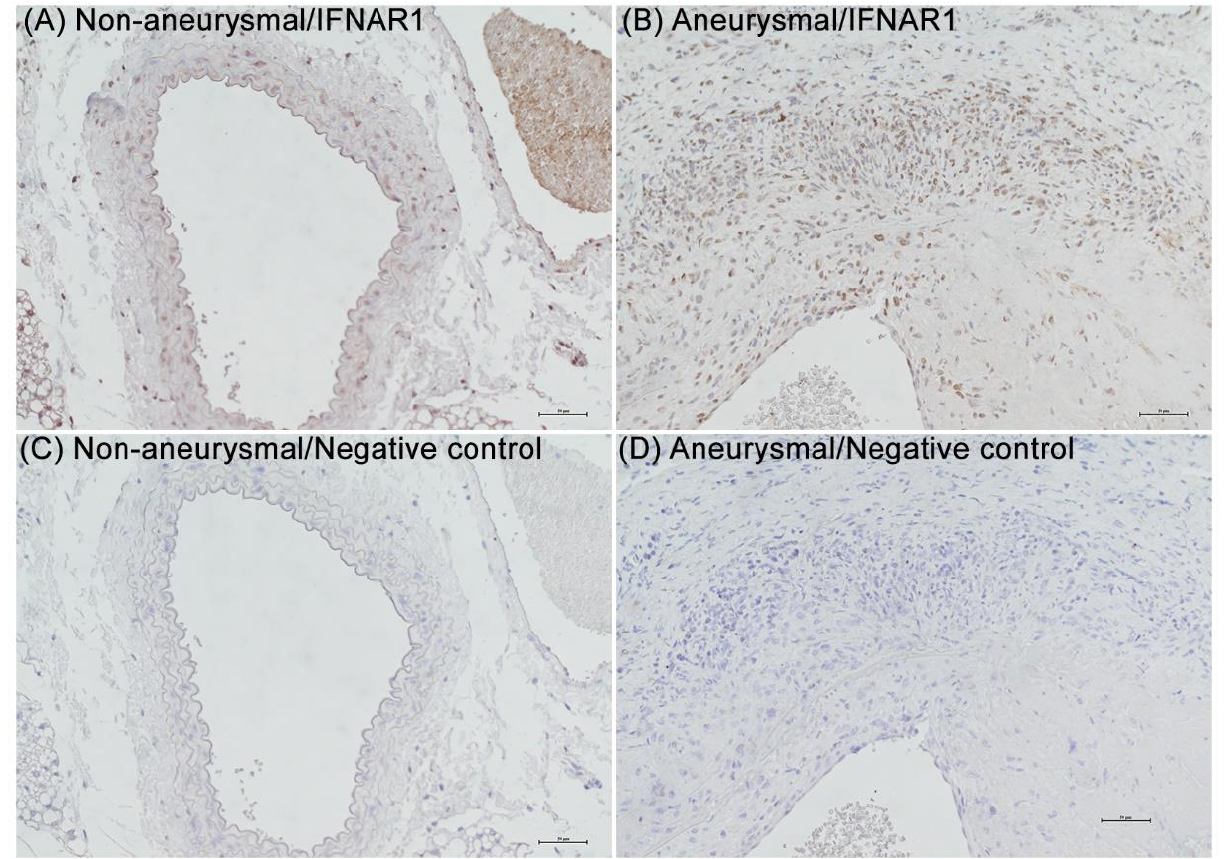
Figure 1. Immunostaining of type I IFN receptor subunit 1 in non-aneurysmal and aneurysmal mouse aortae. Fourteen days following intra-infrarenal aortic elastase (aneurysm group) or phosphate-buffered saline infusion (non-aneurysm group), the involved aorta was harvested, fixed with 10% formalin, embedded in paraffin and sectioned (4 µ m). Sections were stained with a rabbit anti-human type I interferon receptor subunit 1 (IFNAR1) polyclonal antibody (cross-reacts with mouse IFNAR1) or negative control antibody (normal rabbit IgG) via the immunoperoxidase procedure and visualized with peroxidase substrate 3, 3′ -diaminobenzidine. ( A , B ) Representative IFNAR1 staining from non-aneurysmal ( A ) and aneurysmal ( B ) aortae. ( C , D ) No staining with normal rabbit IgG. These results were reproduced in 3 mice in each group. Scale bar: 50 µ m. aneurysmal aortae (Figure 2A,B). In sections obtained from aneurysmal aortae in AAA patients, positive transmural IFNAR1 staining was readily apparent (Figure 2C,H). Positive staining was most pronounced in the adventitia, particularly within leukocyte aggregates (mean and SD: 2.9 ± 2.2) vs. the media (0.2 ± 0.1) ( p < 0.05, 6 patients/group). No staining was seen on non-aneurysmal organ donor (not shown) or aneurysmal (Figure 2I) aortae using control rabbit IgG. Thus, IFNAR1 expression appears increased in both experimental and clinical